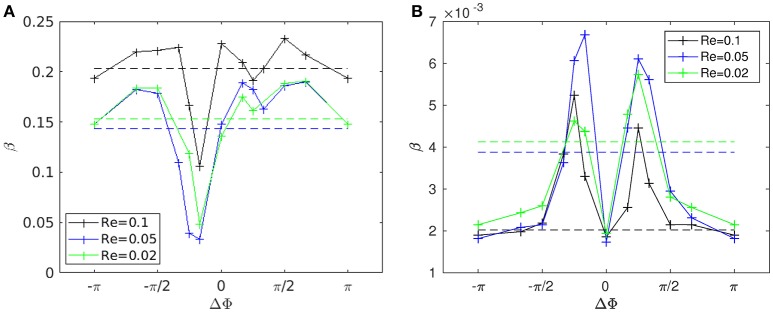
Mixing rate β for different Reynolds numbers (Re = 2.10−2, 5.10−2, and 10−1) as a function of the phase lag ΔΦ. (A) Mixing rate obtained in area 1 with a fit over the 4 first beating cycles. (B) Mixing rate obtained in area 2 with a fit over all 60 beating cycles. The dashed lines represent the values of the mixing rate obtained for cilia beating randomly. Note that the y-scales used in (A,B) are different: the values of β corresponding to area 1 are of order 102 times greater than those obtained in area 2. Also note that the repeatability of the random motion has been tested, and similar values for β with less than 2% of difference were found.